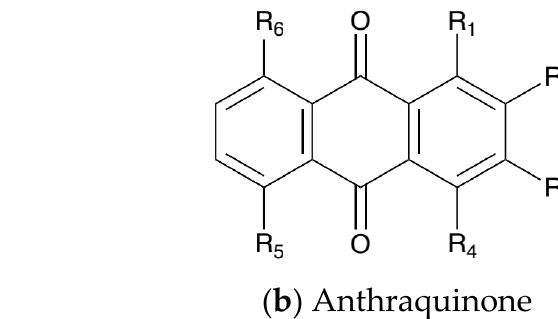
Figure 8. Structural skeletons of most monoazo ( a ) and anthraquinone ( b ) disperse dyes [139].